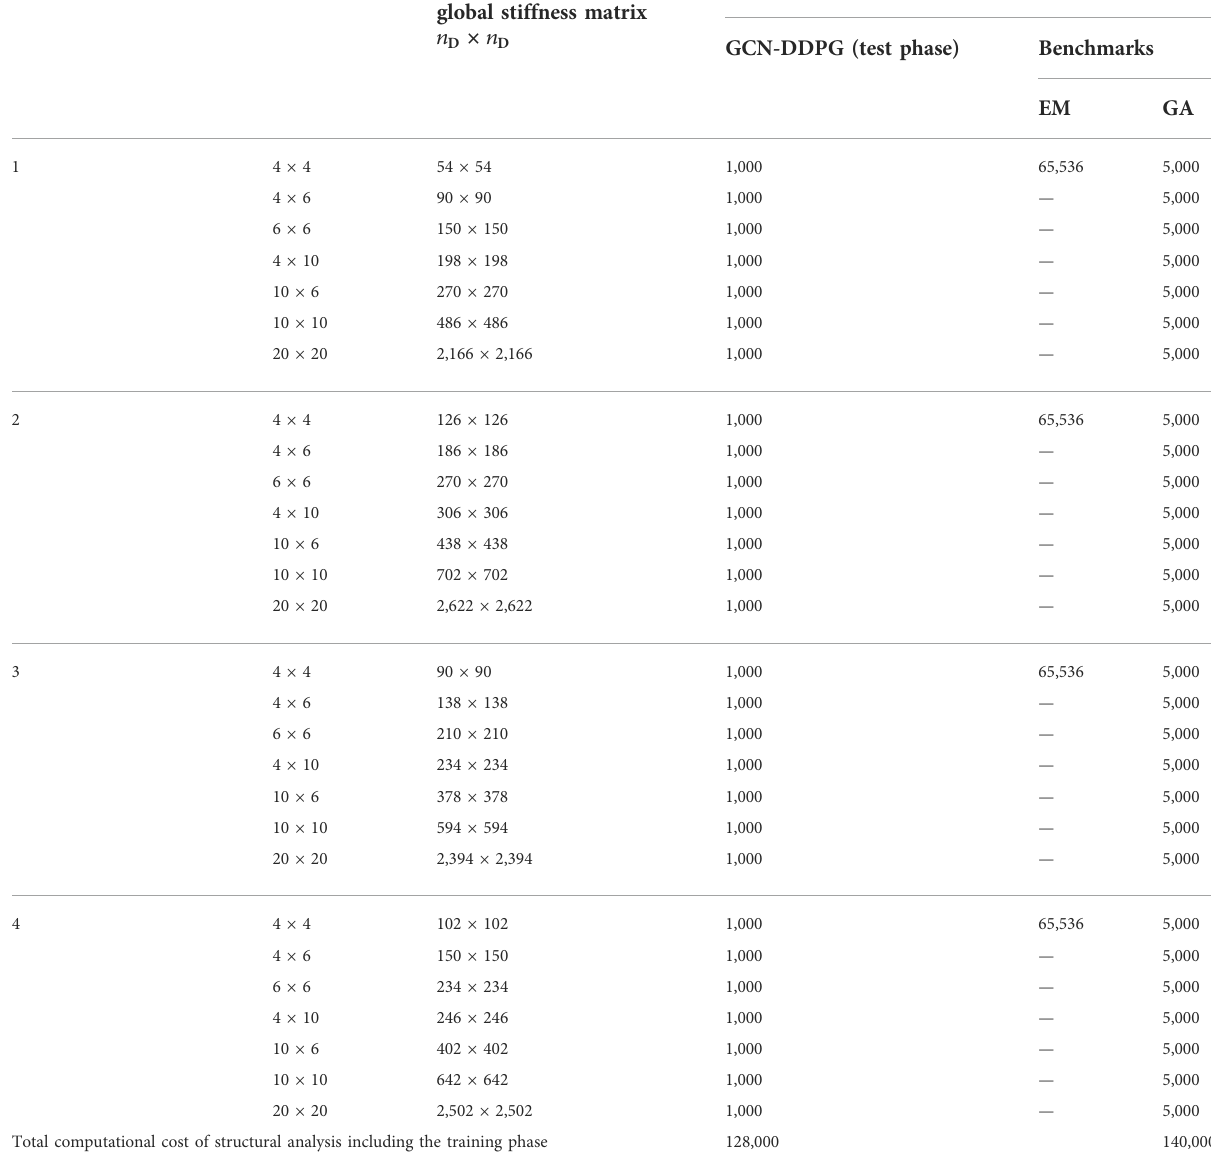
TABLE 3 Total computational cost of structural analysis of each